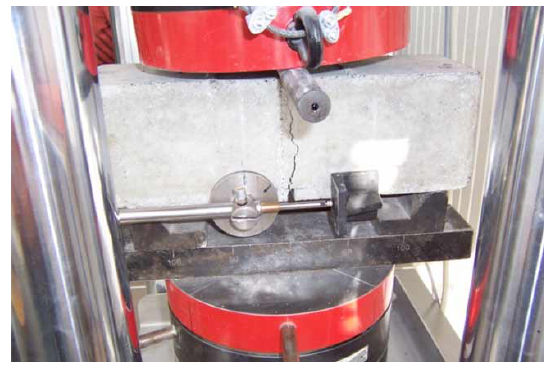
Fig. 3. Sample CMOD measuring sensor